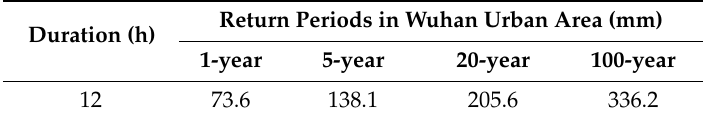
Table 1. The precipitation of short-duration rainfall in the urban area of Wuhan (mm) [35]. Return Periods in Wuhan Urban Area Duration (h)